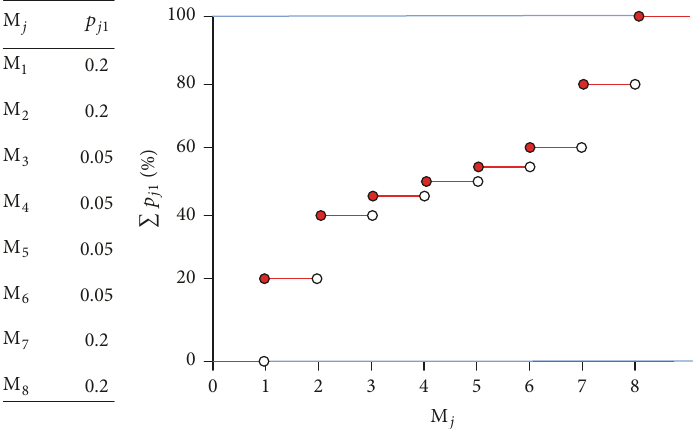
Figure 2: Values of probabilities 𝑝 𝑗𝑘 and their distribution function.